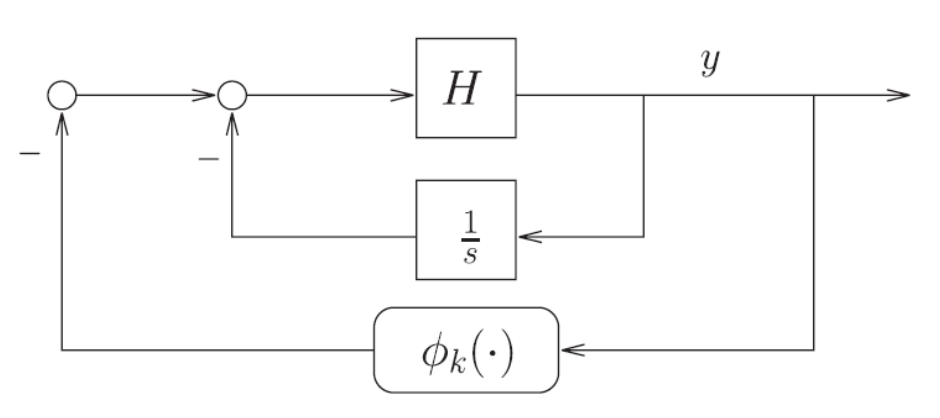
Figure 3. Forcing the Hopf bifurcation with an integrator in the feedback loop and H passive. The case H ( s ) = 1 /s corresponds to Lienard